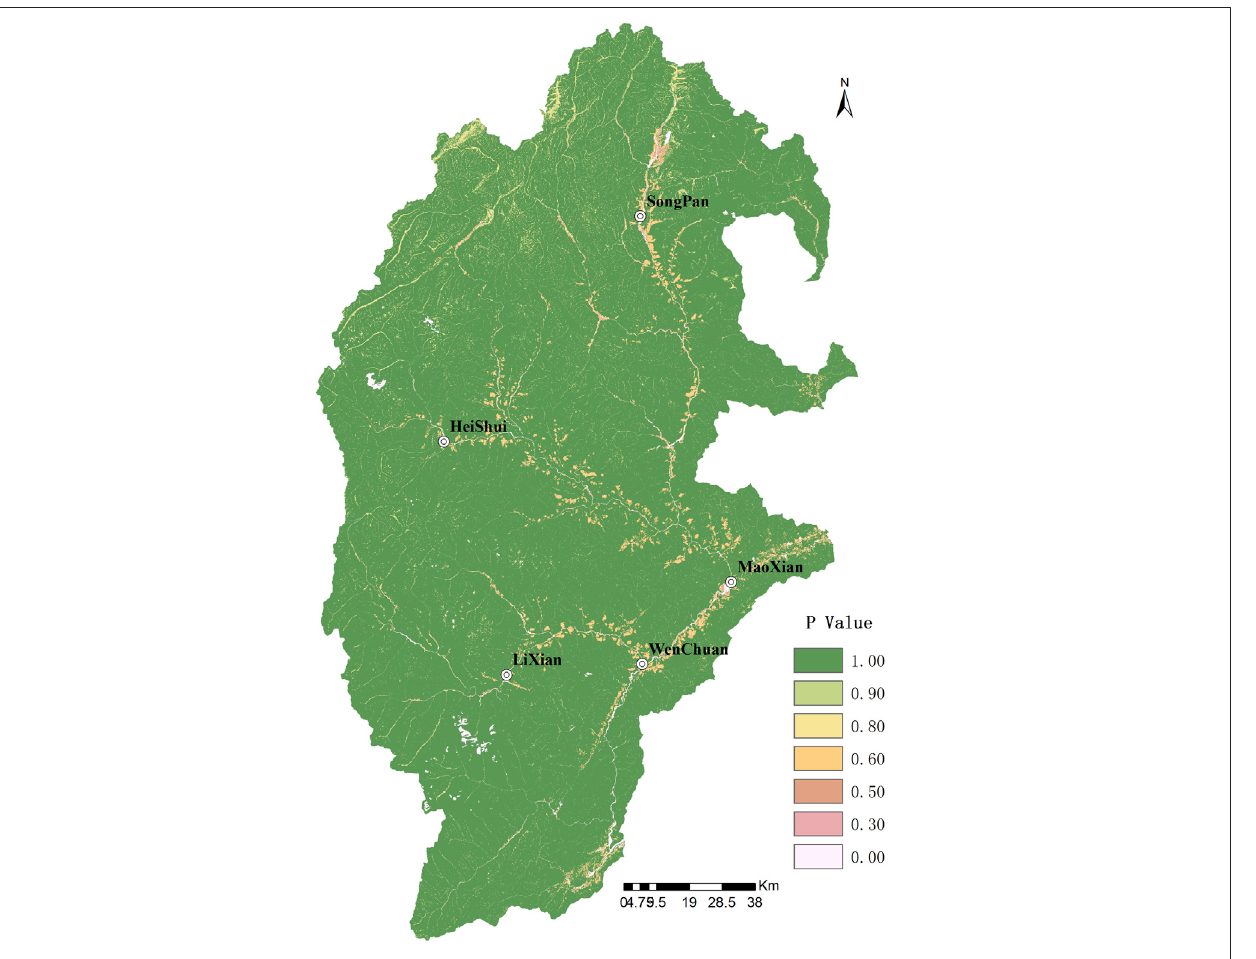
FIGURE 7 | P value of the upper reaches of Minjiang